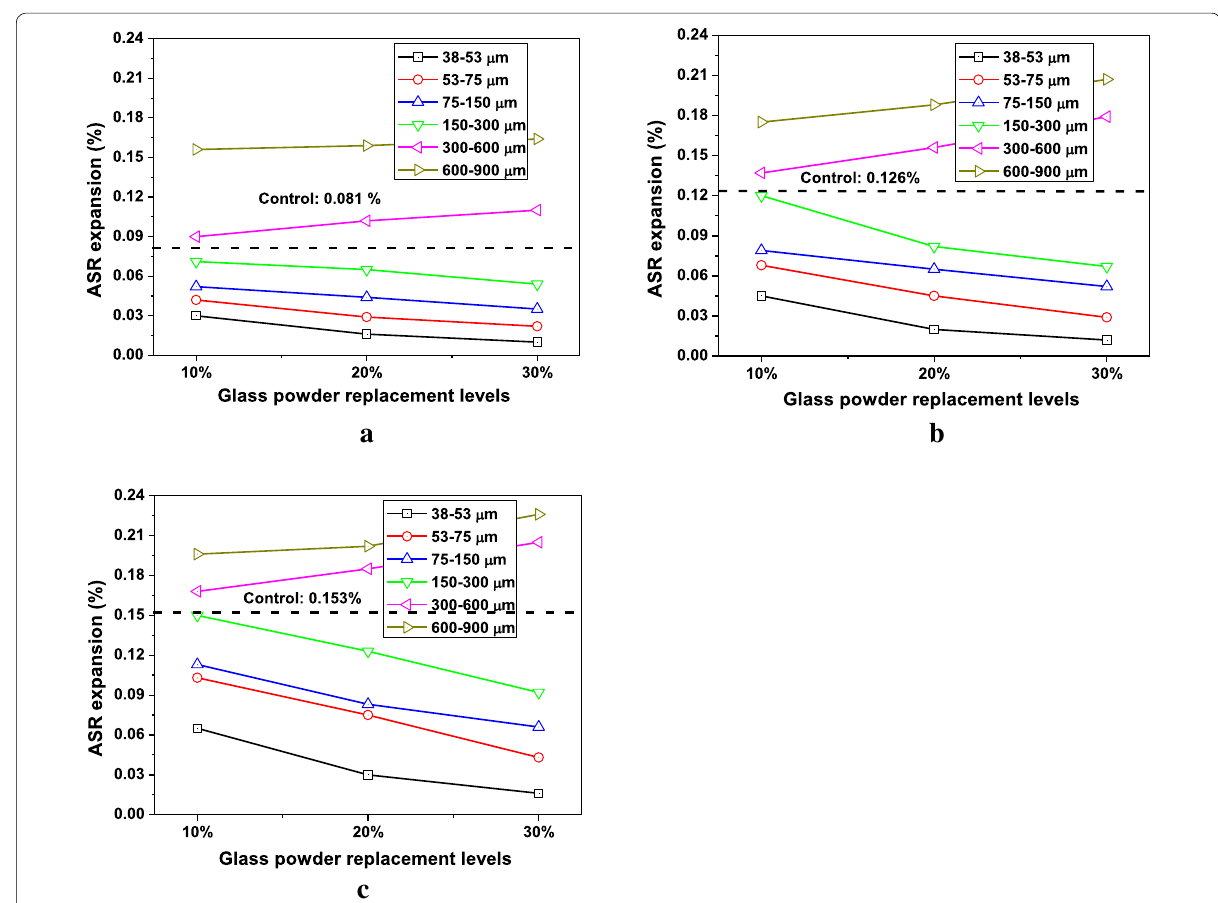
Fig. 4 Effect of the content of waste glass powder on ASR expansion of cement mortar bars at different curing ages. a Curing age of 14 days, b curing age of 28 days, c curing age of 35